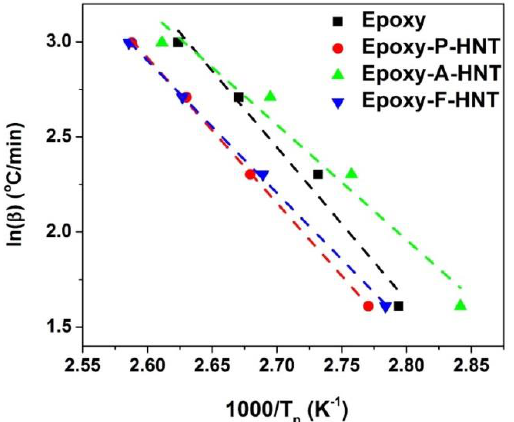
Figure 8. Plots of ln( β i ) vs. 1 / T for neat epoxy, epoxy / P-HNT, epoxy / A-HNT and epoxy / F-HNT nanocomposites based on FWO model.